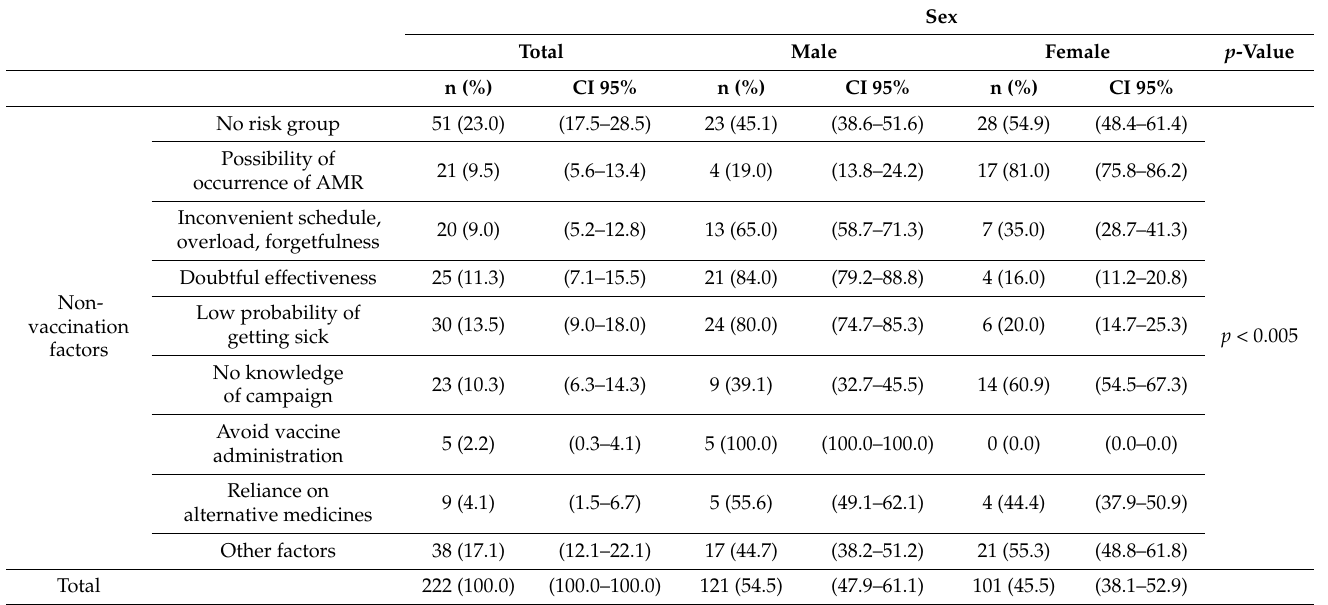
Table 3. Non-vaccination factors.